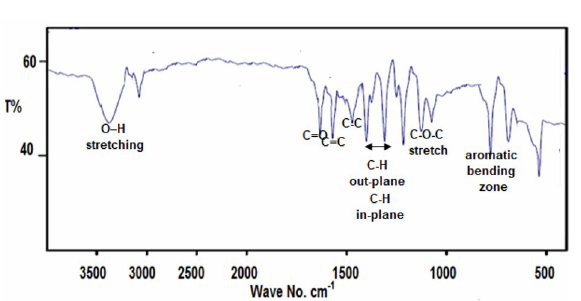
Figure 10. FT-IR spectra of the film formed on the surface of X52-steel in the inhibited solution (1.0 M HCl + 400 mg L −1 of BLE